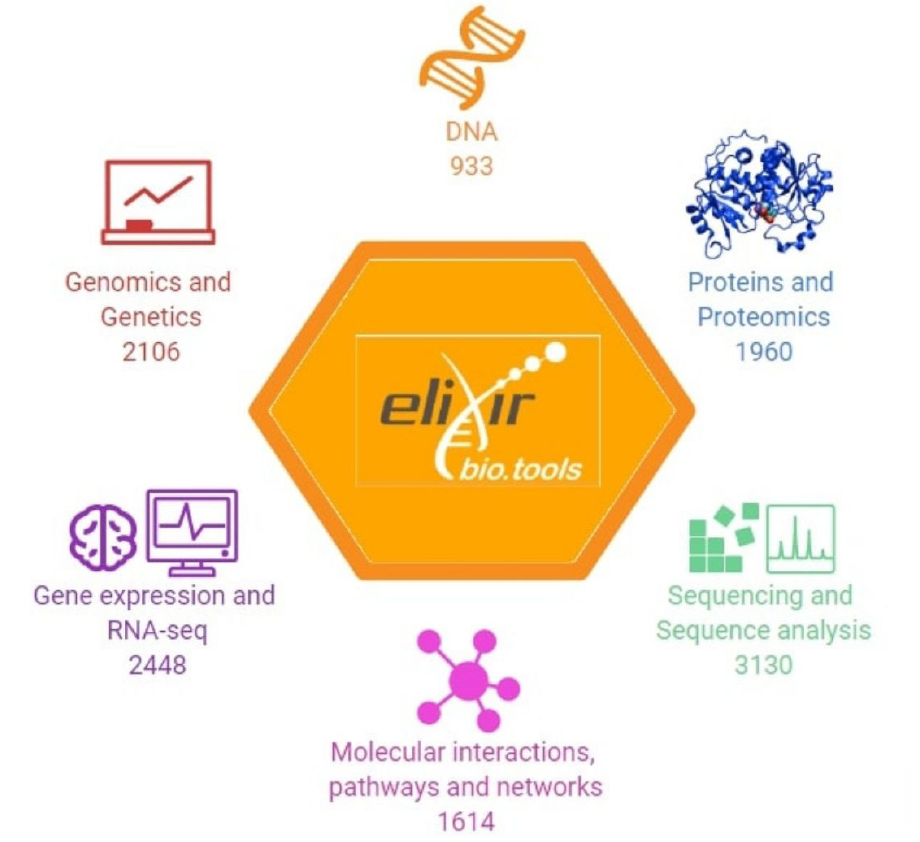
Figure 3 – Bio.tools databases ordered by